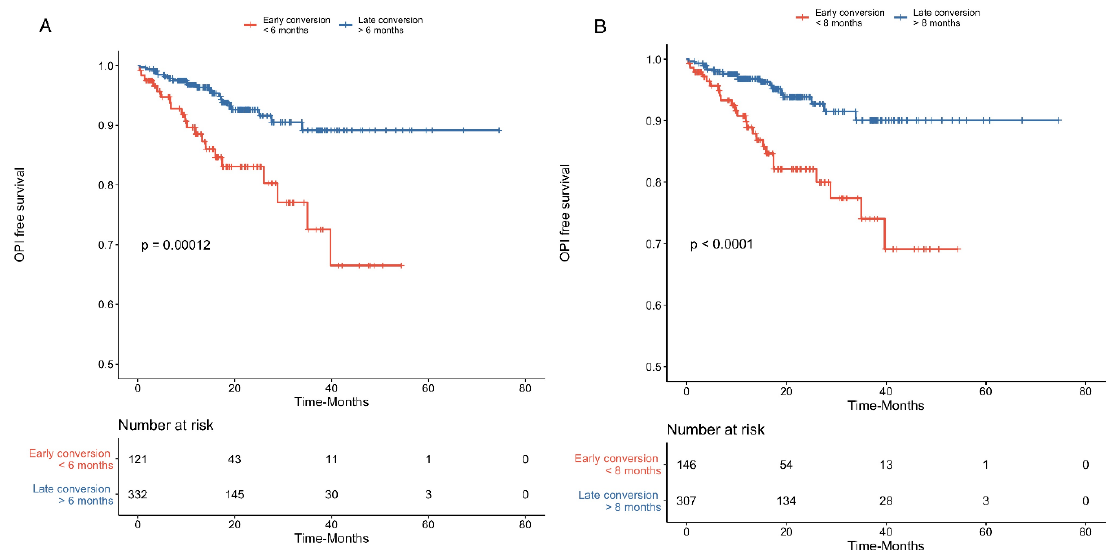
Figure 2. Early conversion to belatacept as a risk factor for an opportunistic infection (OPI). Kaplan–Meier analysis curve of OPI-free survival in kidney transplant recipients converted earlier ( < 6-months) and later ( ≥ 6-months) to belatacept ( A ) and of recipients converted to belatacept before < 8-months and after ≥ 8-months ( B ).